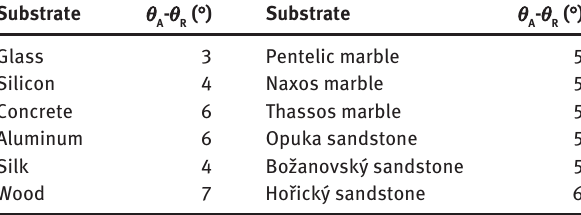
- θ ) measured on various sur- A R